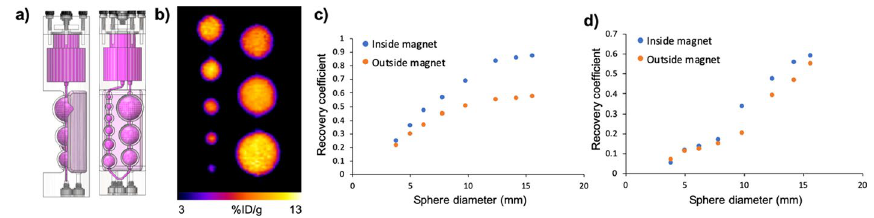
Fig. 4 PET partial volume effects in the presence of the MRI instrument. a A schematic of the PVC phantom (image reproduced with permission from Phantech Medical). b A representative PET image of the phantom. c The phantom with 5.55 MBq (150 µCi) of fluorine-18 was placed in axial center of the PET insert inside